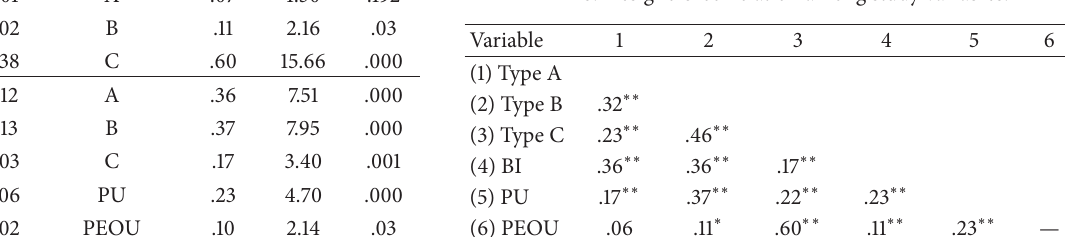
Table 8: Designers’ correlation among study